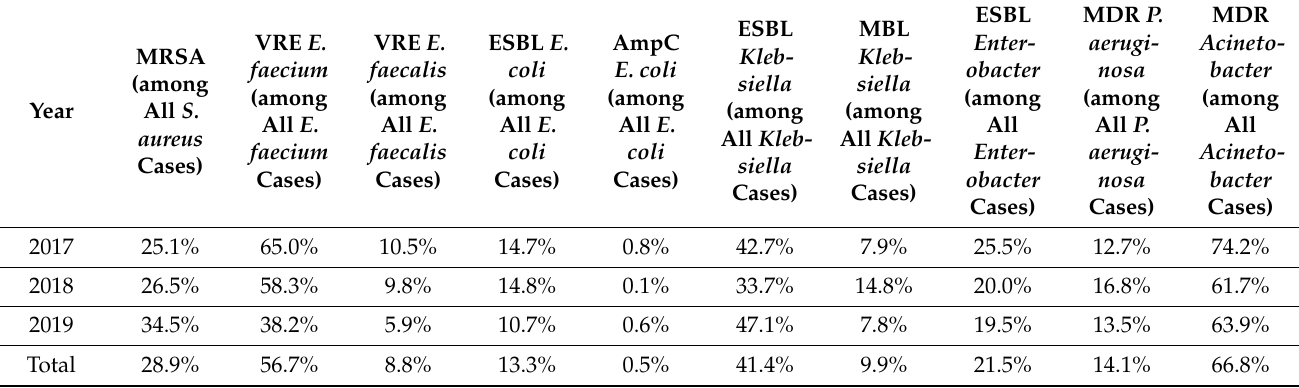
Table 5. The percentage (number of MDR infections to all infections) of infections caused by multidrug resistant bacteria depending on year of